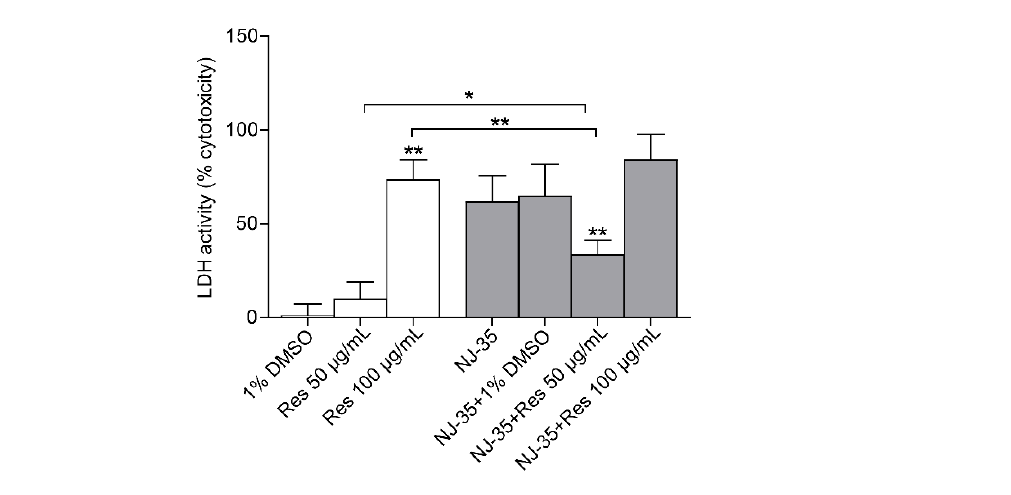
Figure 4. LDH release of J774A.1 cells with or without A. hydrophila NJ-35 treatment, and the indicated concentrations of resveratrol. The data were presented as the mean ± SD (n = 6). * p < 0.05, ** p < 0.01.